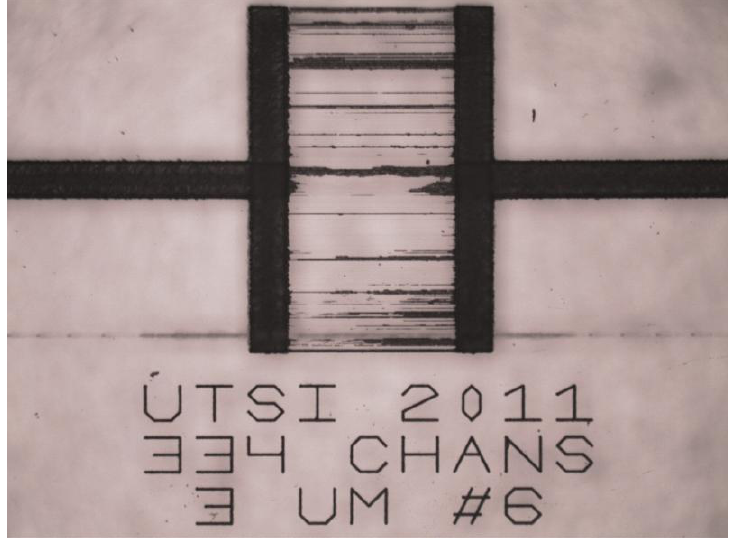
Figure 2. Optical micrograph of microchannels machined in SiO 10 M KOH solution for 24